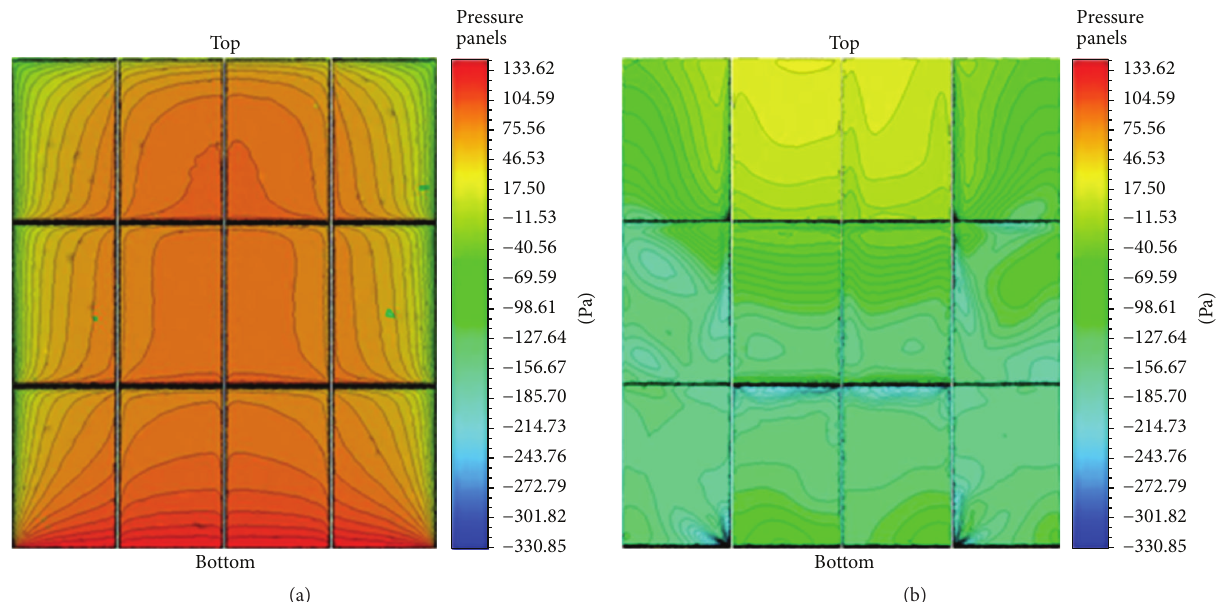
Figure 10: Static pressure (N/m 2 ) contours at conventional panels: (a) upwind side and (b) downwind side.